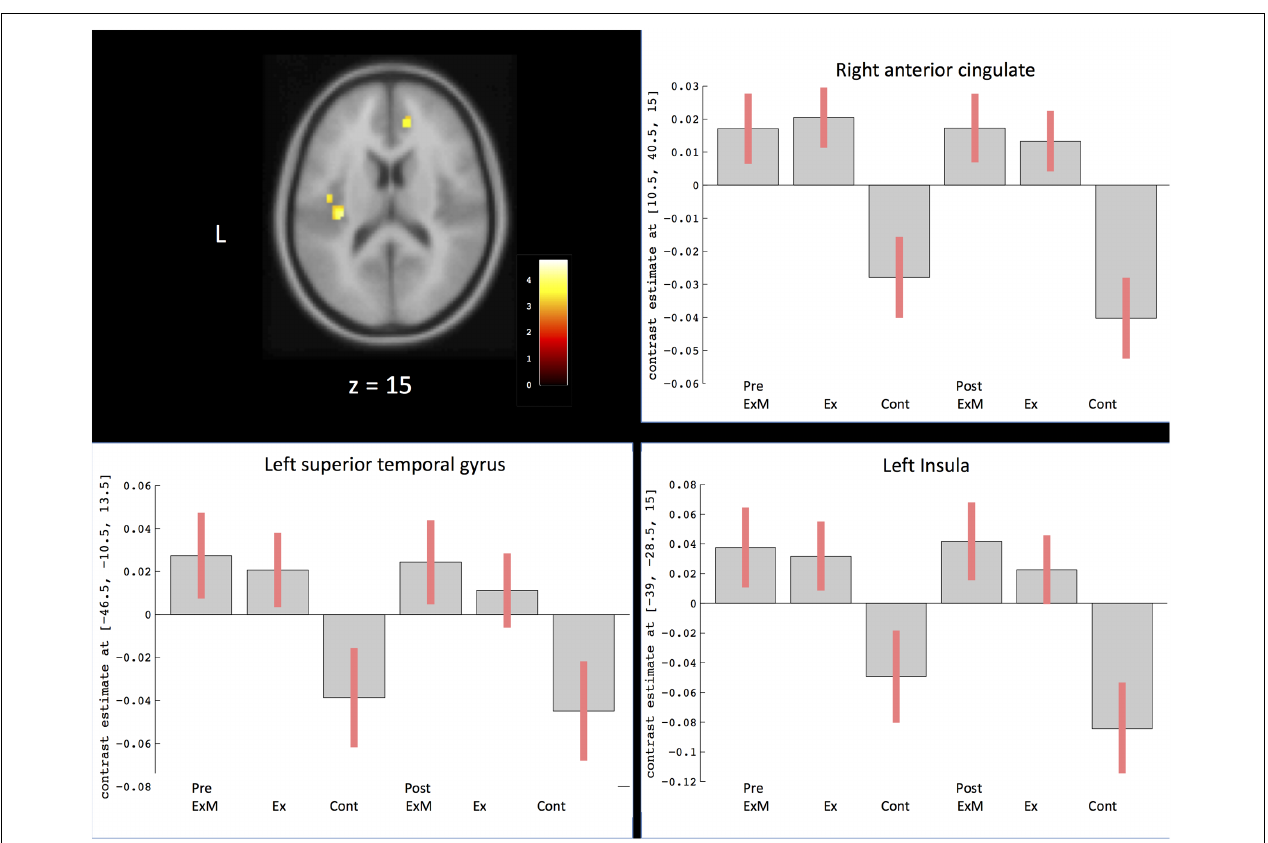
FIGURE 5 | Region showing regional gray matter volume correlated with visuospatial assessment. The axis of ordinate displays changes based on β parameter estimates (with 90% confidence intervals) of the peak voxels within the respective clusters in each group pre- and post-intervention. Cont, control group; Ex, physical exercise without music group; ExM, physical exercise with music